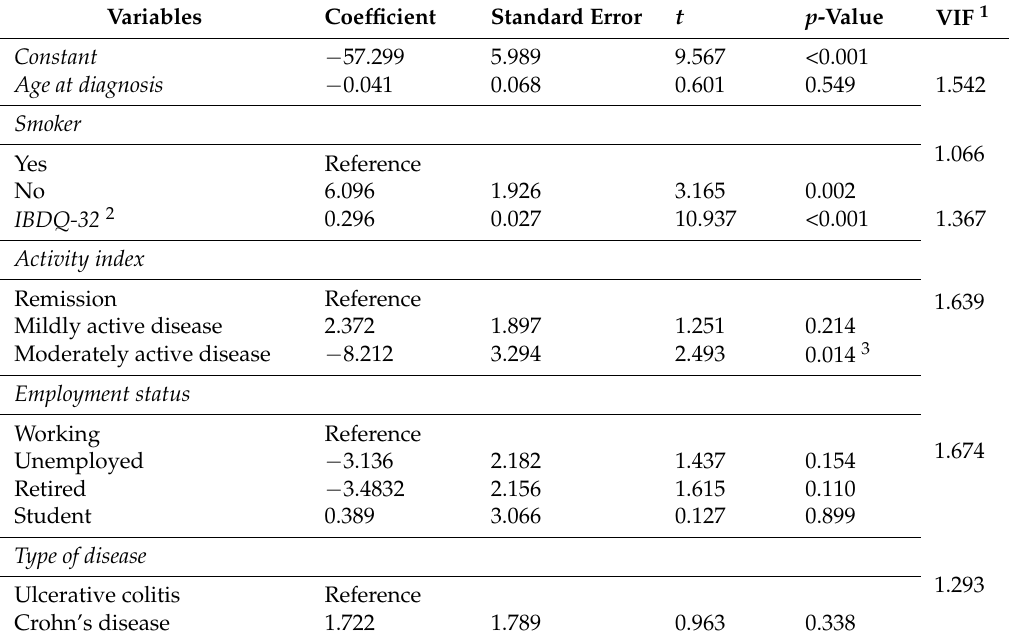
Table 4. Inflammatory Bowel Disease Disability Index linear regression model for